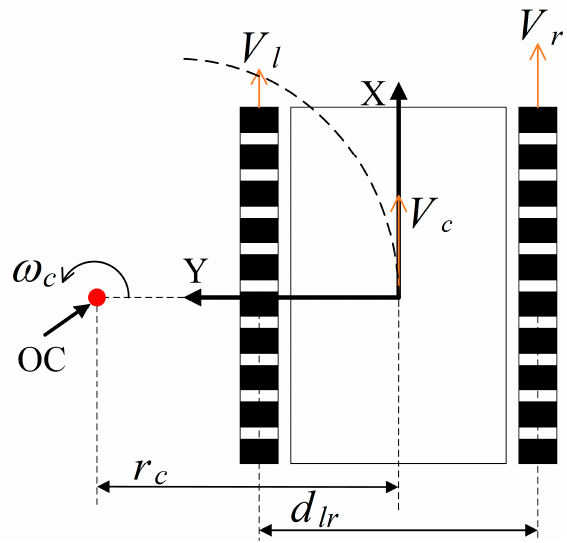
Figure 7. The kinematic model of the spraying robot.